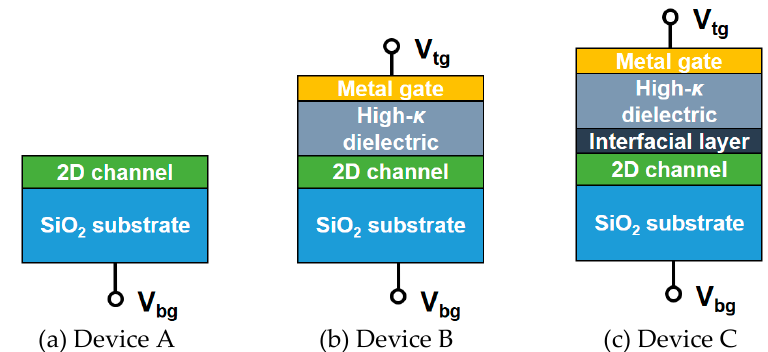
Figure 1. Simulated device structure with atomically thin InSe channel in this work. ( a ) Back-gate InSe field-effect transistors (FET) with SiO 2 substrate as gate dielectric. ( b ) Dual-gate InSe FET with high- κ dielectric as top-gate dielectric and SiO 2 substrate as back-gate dielectric. ( c ) The same structure as ( b ) with additional SiO 2 interfacial layer embedded between the InSe channel and high- κ dielectric. For the dual-gate structure, high- κ dielectric is covered with a metal gate. Table 1. Parameters for the polar phonons in some high- κ materials [20]